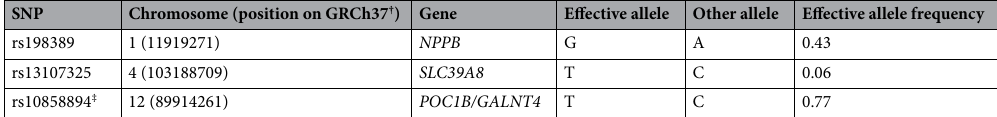
Table 1. Overview of loci associated with increasing NT-proBNP levels selected according to Johansson et al. 16 . † Genome Reference Consortium human build 37, version of a reference genome. ‡ Proxy for rs11105306 in perfect linkage disequilibrium (R 2 =